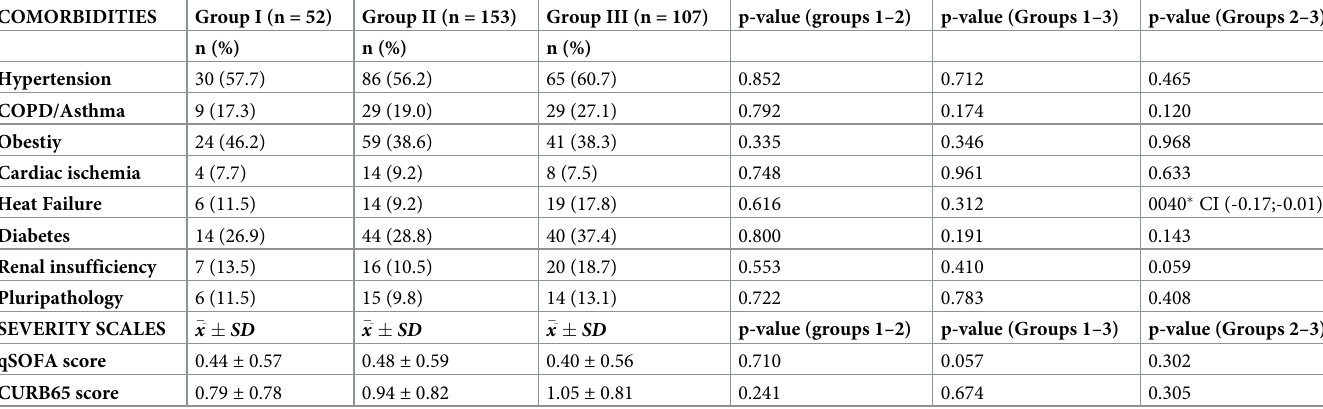
Table 1. Comorbidities and severity scales at admission for the different treatment